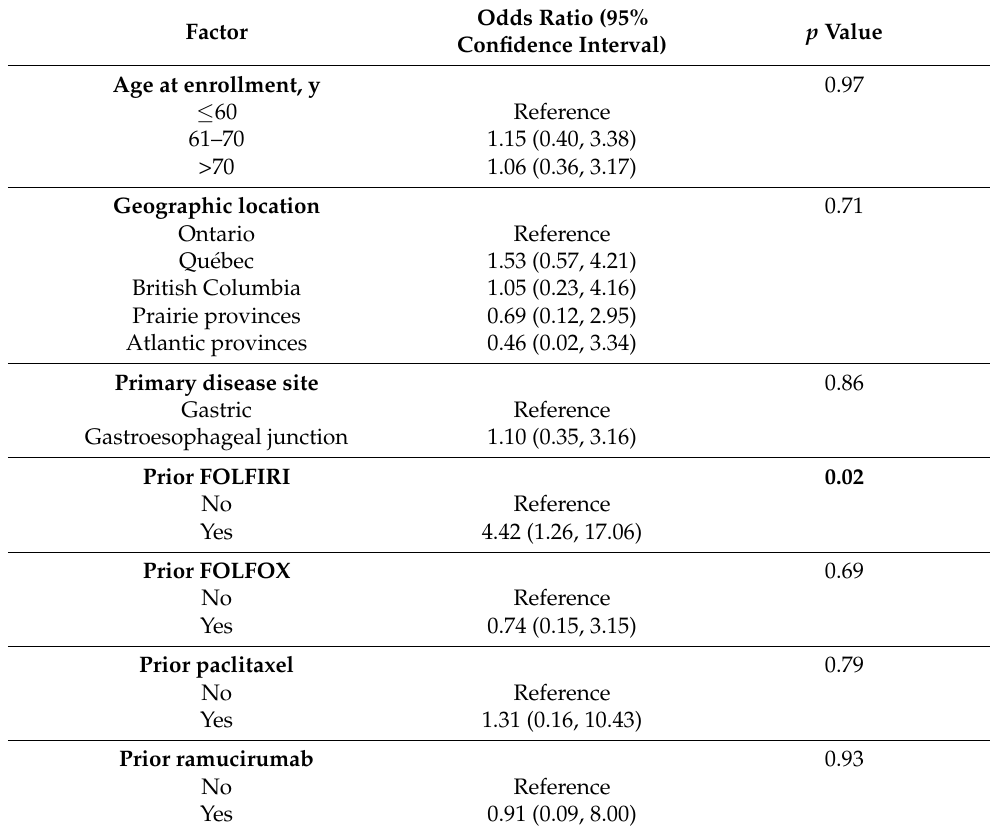
Table 6. Multivariable logistic regression analysis of predictors of trifluridine/tipiracil dose reduction or